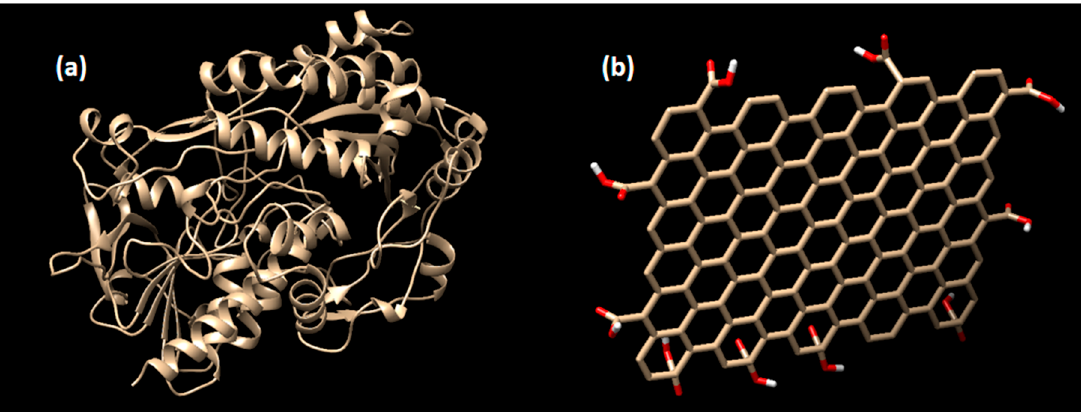
Figure 1. The structure of ( a ) glucose oxidase enzyme receptor (PDB: 1CF3), and ( b ) the graphene oxide. Note that the pictures are not to scale.